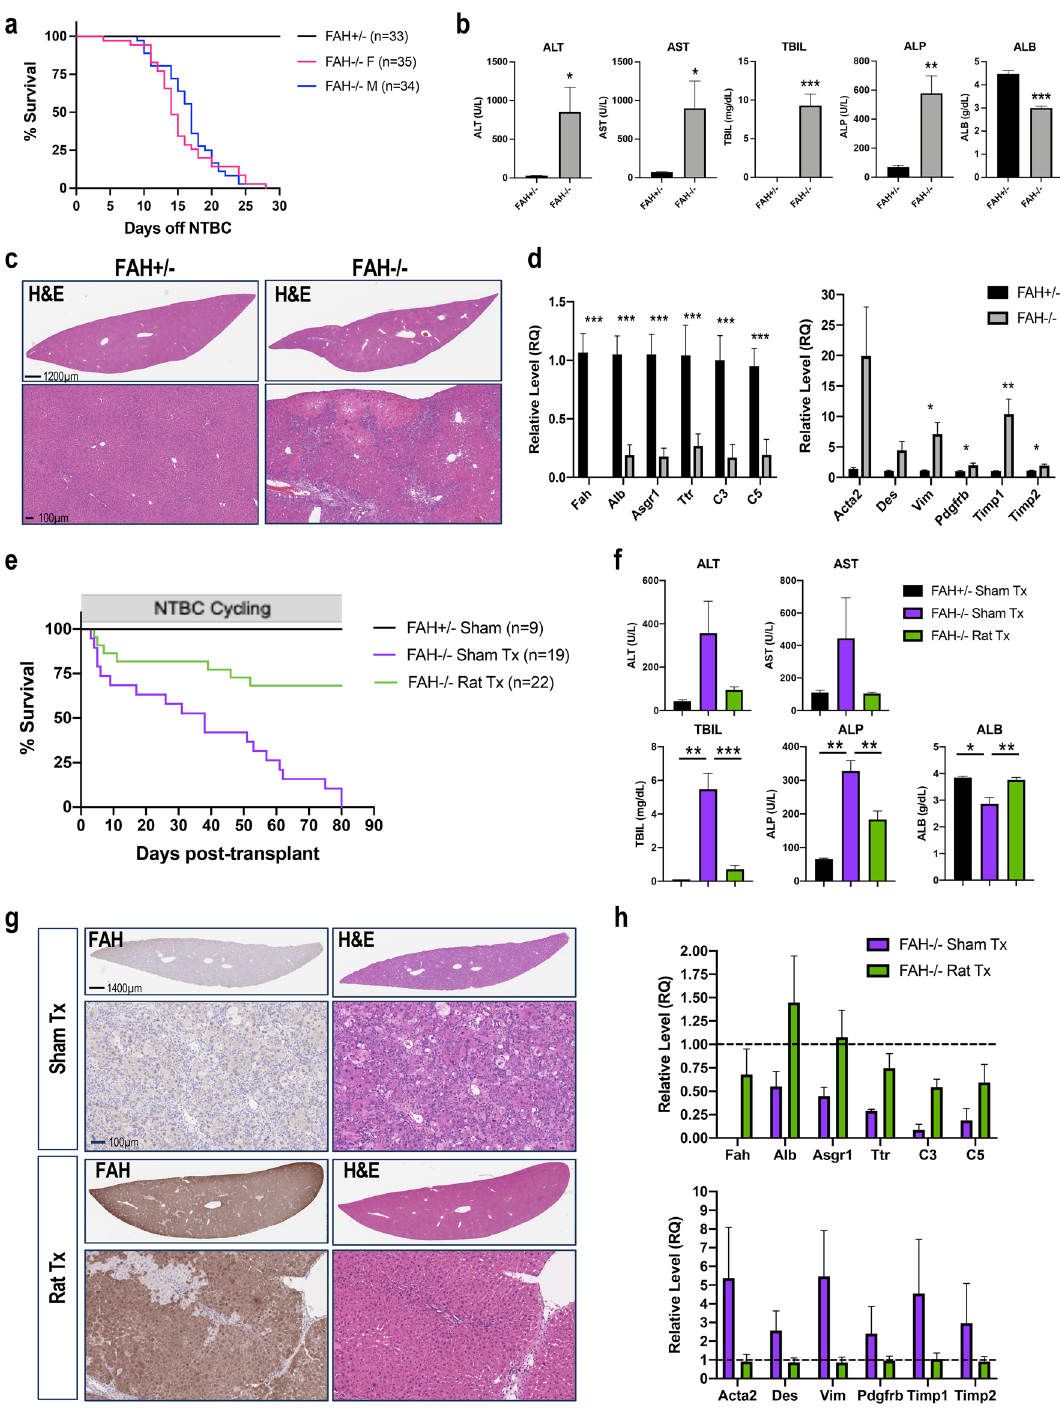
Figure 2. Engraftment of wildtype rat hepatocytes rescues lethal phenotype of FRG rats. ( a ) Kaplan–Meier survival curves of male and female Fah +/− (n = 33) and Fah −/− (n = 35F, 34M) rats after NTBC removal. ( b ) Serum ALT, AST, TBIL, ALP and ALB from terminal bleeds from 10 Fah +/− and 13 Fah −/− rats at day 14–20 after NTBC withdrawal. ( c ) H&E staining from one representative Fah +/− and Fah −/− showing extensive liver damage with NTBC withdrawal. ( d ) TaqMan real-time PCR data showing a decrease in hepatocyte-expressed genes (left) and an increase in fibrogenesis-related genes (right) in Fah −/− vs. Fah +/− rats. ( e ) Survival curve of Fah +/− (n = 9) rats or Fah −/− , with (n = 22) or without (n = 19) a transplant of wild-type rat hepatocytes, while following an NTBC cycling schedule. ( f ) Serum ALT, AST, TBIL, ALP and ALB levels of rats after sham surgery vs. rat hepatocyte transplant. ( g ) H&E and FAH IHC showing repopulation of the FRG rat liver with wild-type rat hepatocytes. ( h ) TaqMan data showing a rescue of gene changes in Fah −/− rats repopulated with wild-type hepatocytes vs. Fah −/− rats that received sham surgery, relative to Fah +/− rats with no liver damage (dotted line). Data in ( b ), ( d ) and ( f ) shown as mean ± SEM. *p < 0.05, **p < 0.01, ***p < 0.001, Unpaired t